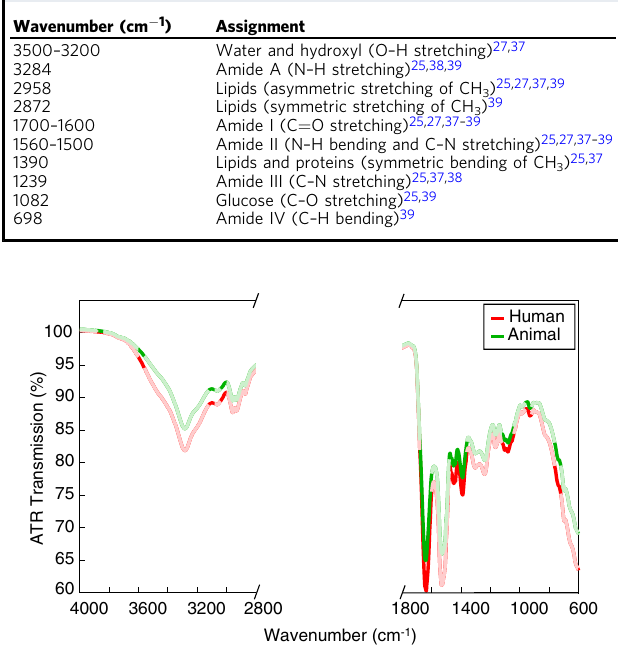
Fig. 2 The averaged raw ATR FT-IR spectra of human blood (red) and animal blood (green). Featured spectral regions were selected by a genetic algorithm.